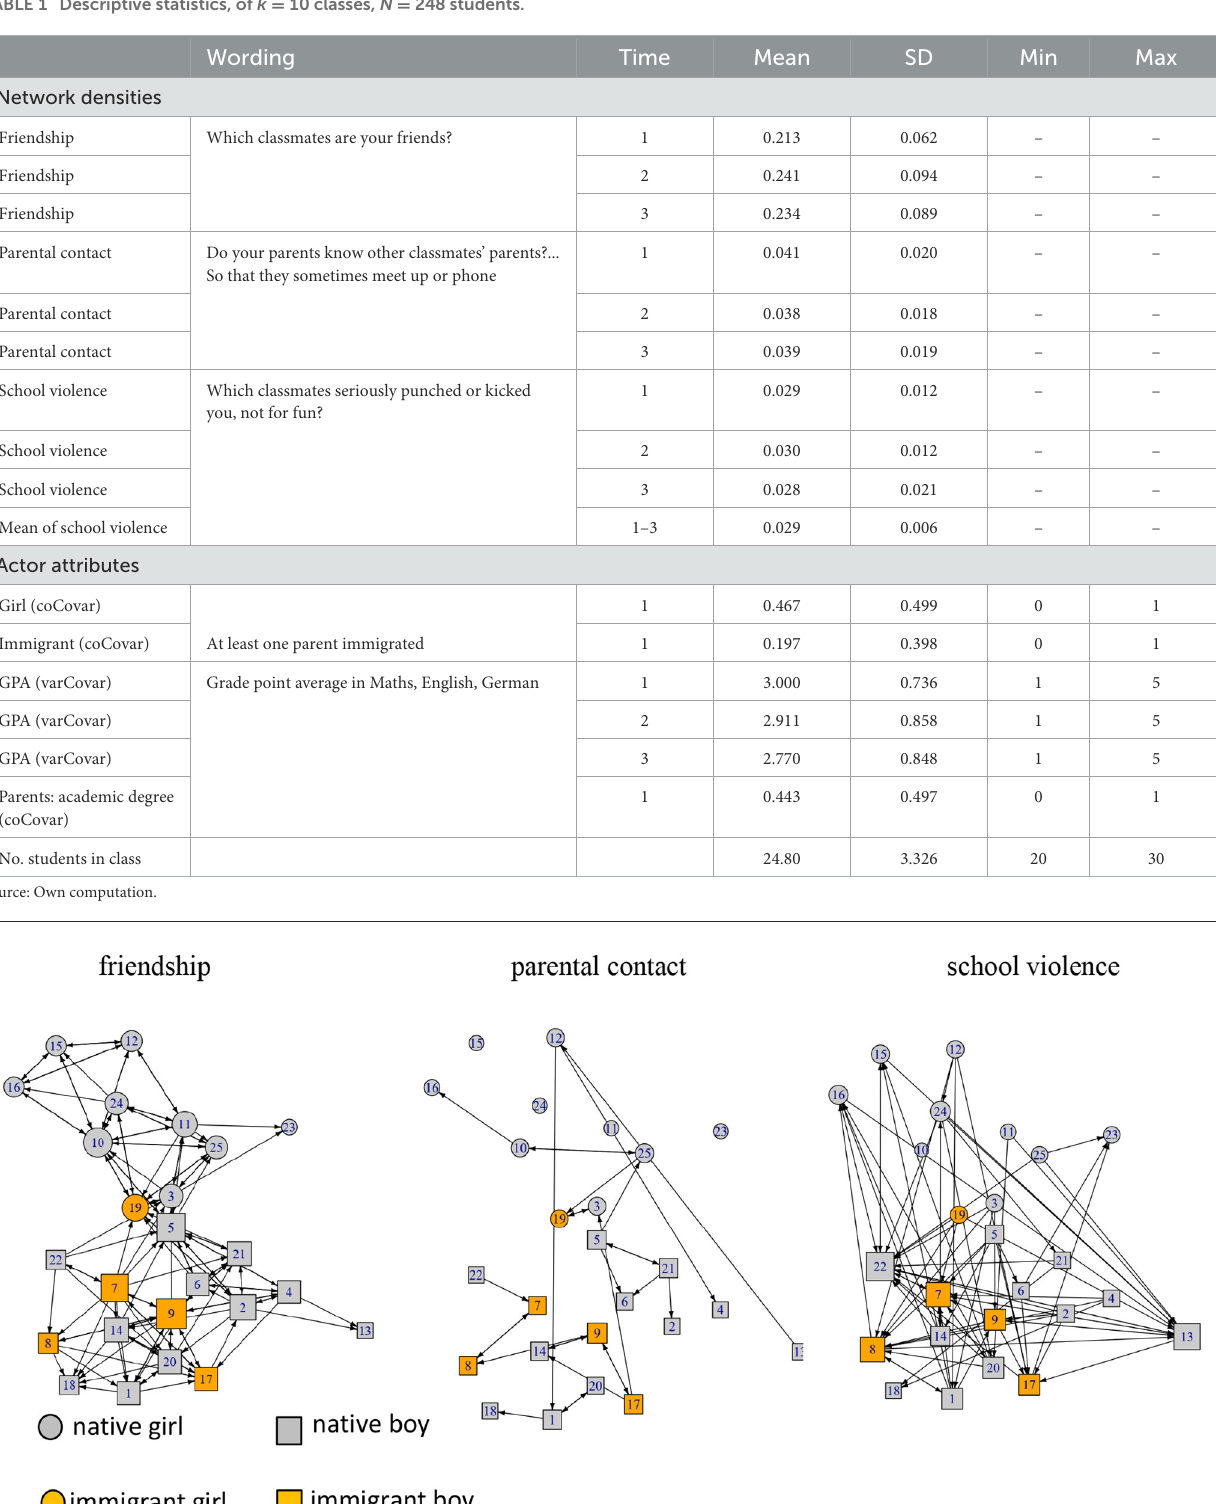
children become befriended, parents become involved, but need some time to establish norms, which need some additional time to affect children’s behavior.